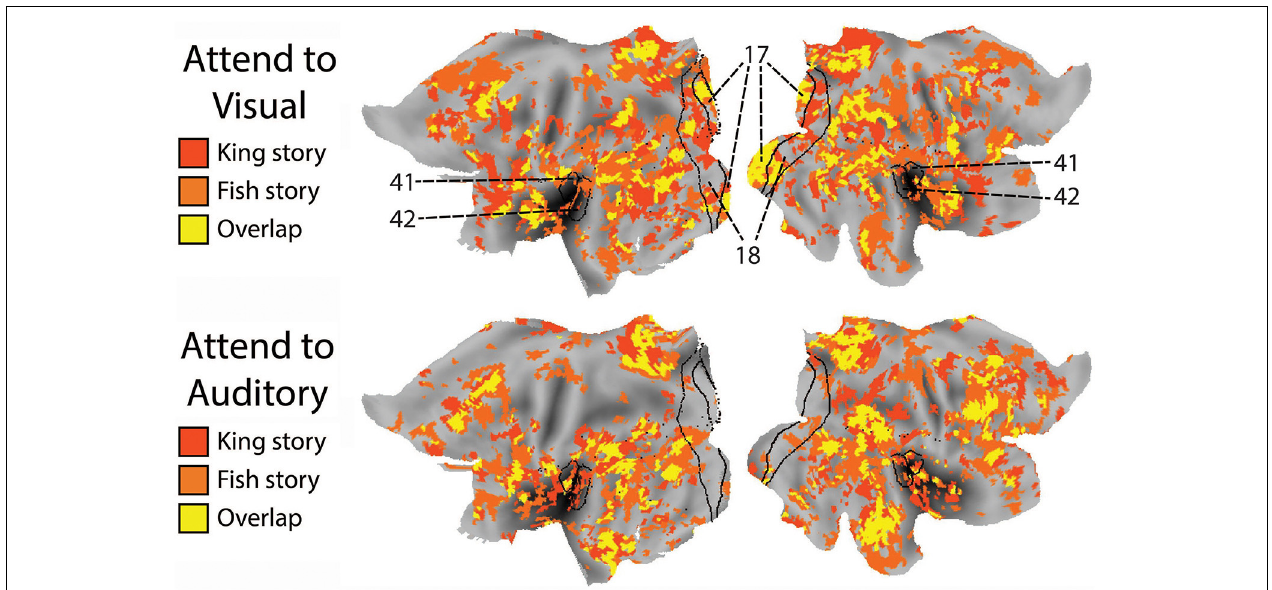
FIGURE 5 | The effect of attended modality on brain areas contributing to ongoing cognition. Top: Putative brain areas underlying ongoing cognition identified in the AV condition were combined across the two stories (i.e., the yellow regions in Figure 4 , left column). Bottom: Putative brain areas